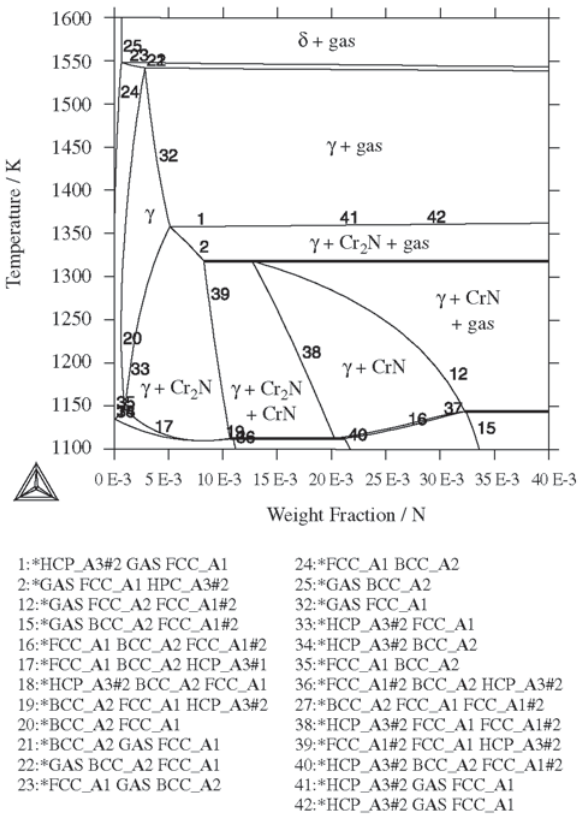
Figure 2. Isopleth of the Fe- 13% Cr – N system for 0.15 MPa N pressure.